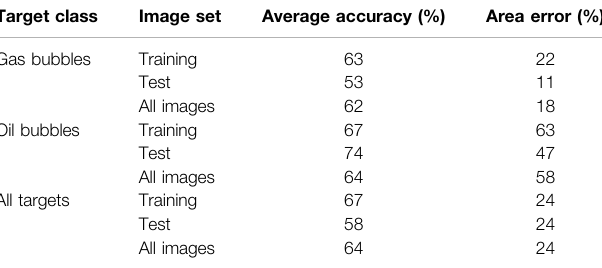
TABLE1| AveragerecognitionandareaaccuracyachievedbytheR-CNNbubble recognition algorithm. Target